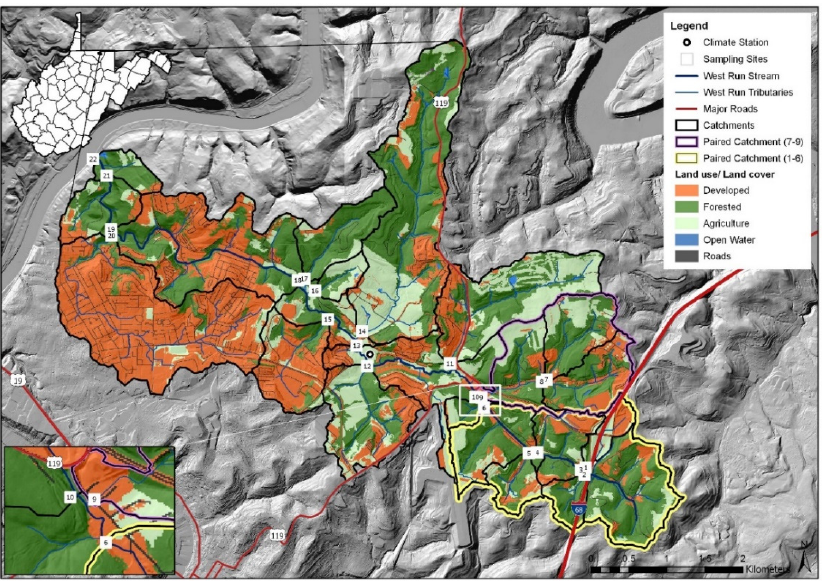
Figure 1. Land use/ land cover of West Run Watershed, Morgantown, WV, USA, including Figure 1. Land use / land cover of West Run Watershed, Morgantown, WV, USA, including monitoring / monitoring/sampling locations for the current investigation. sampling locations for the current